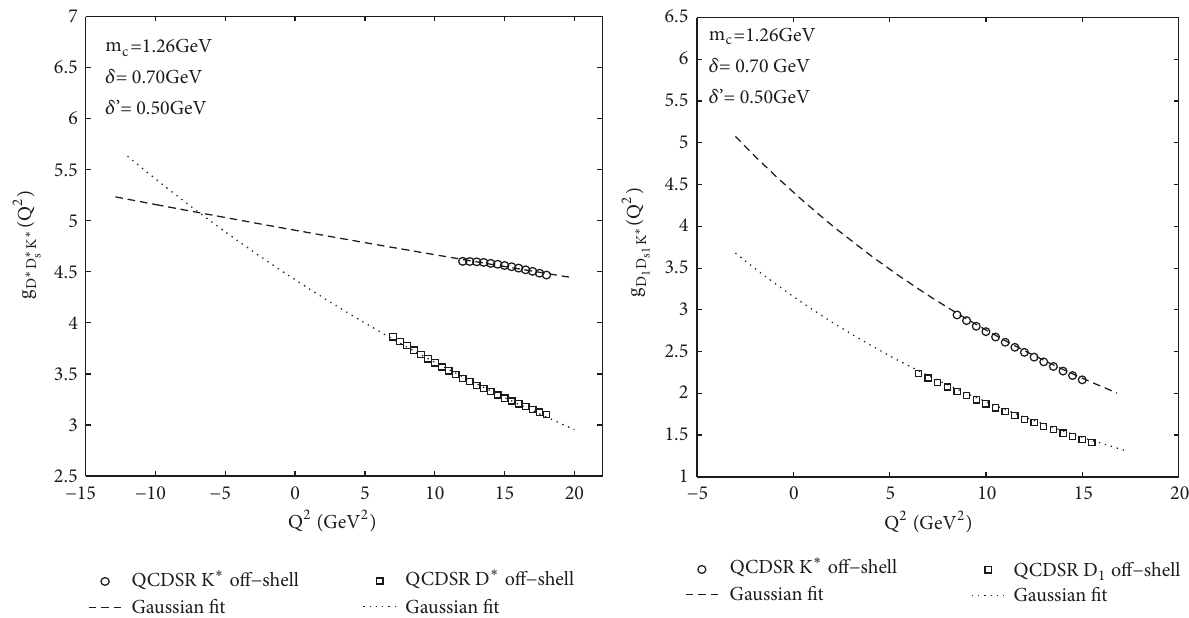
Figure 5: The strong form factors 𝑔 퐷 ∗